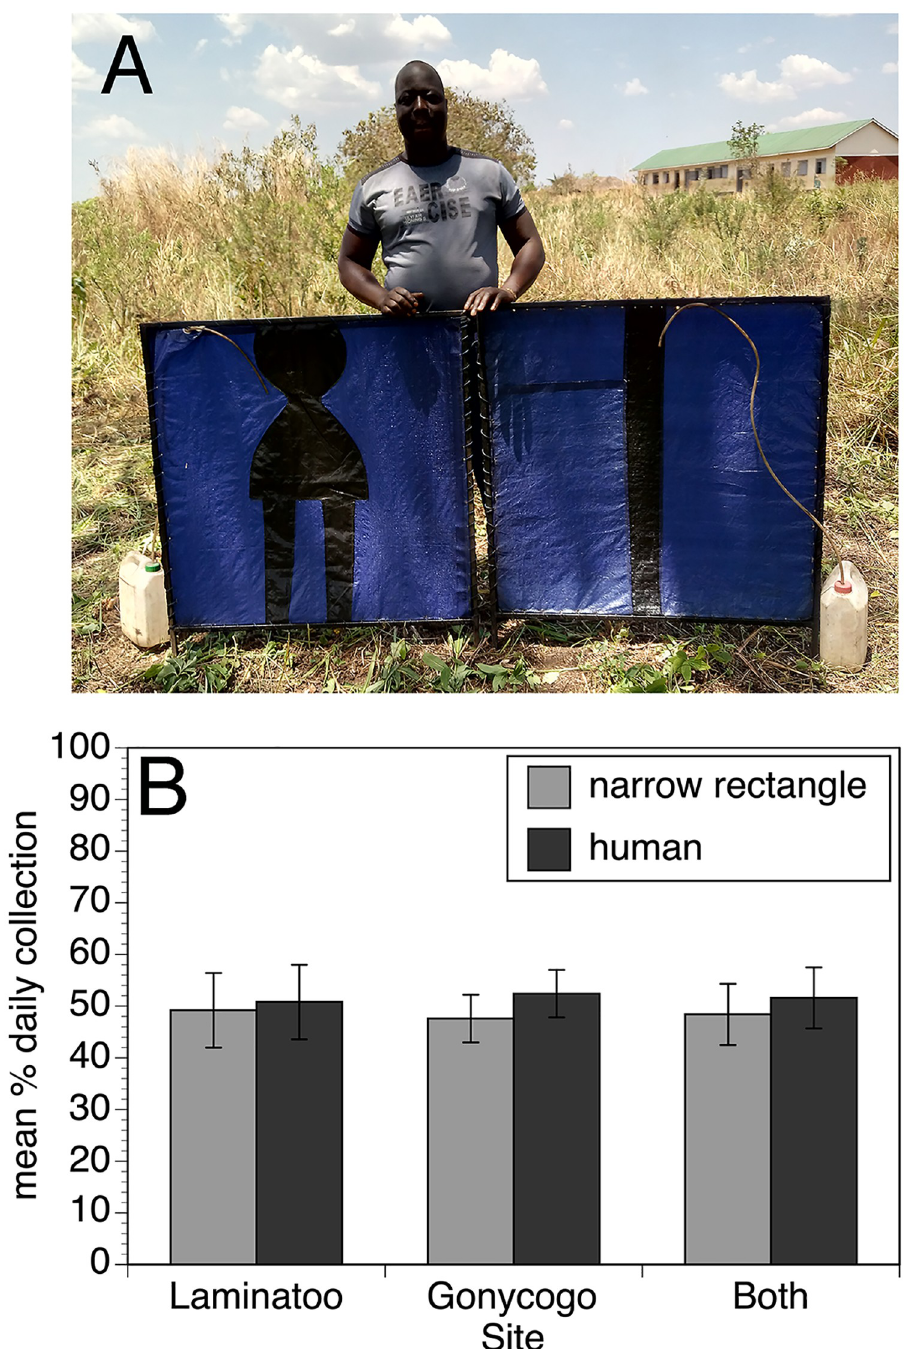
Fig 5. Relative performance of simple and human shaped stripe designs. Panel A: Photograph of the simple narrow stripe and human shaped stripe trap designs. Panel B: Relative performance of the simple narrow stripe and human shaped stripe trap designs in Laminatoo, Gonycogo and data from both communities combined. Data are presented as the mean percentage of the total collection by day, normalizing for variations in the absolute number of flies collected on each day, as described in Materials and Methods. Error bars indicate the standard deviation associated with the means. The analysis was conducted on data collected from 30 paired trials each in Laminatoo and Gonycogo. Raw collection data for this study may be found in the S4